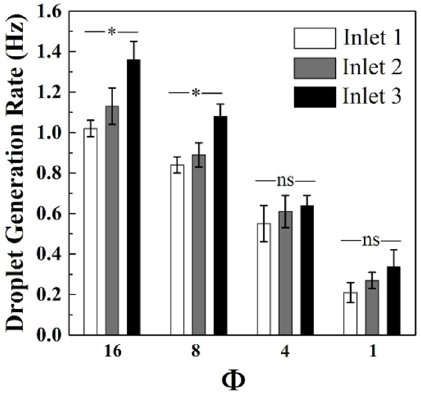
Figure 5. Droplet generation rate decreased as the oil-to-water ratio ( Φ ) value decreased in triple active gravity-driven experiments. The relationship between Φ and the generation rate was elucidated using all three active inlets. The mean droplet diameters from the three different inlets at the same oil-to-water ratio were significantly different for given Φ = 8 and 16. For each inlet, 30 droplets were measured, and the results are representative of three trials, with * denoting p > 0.05.